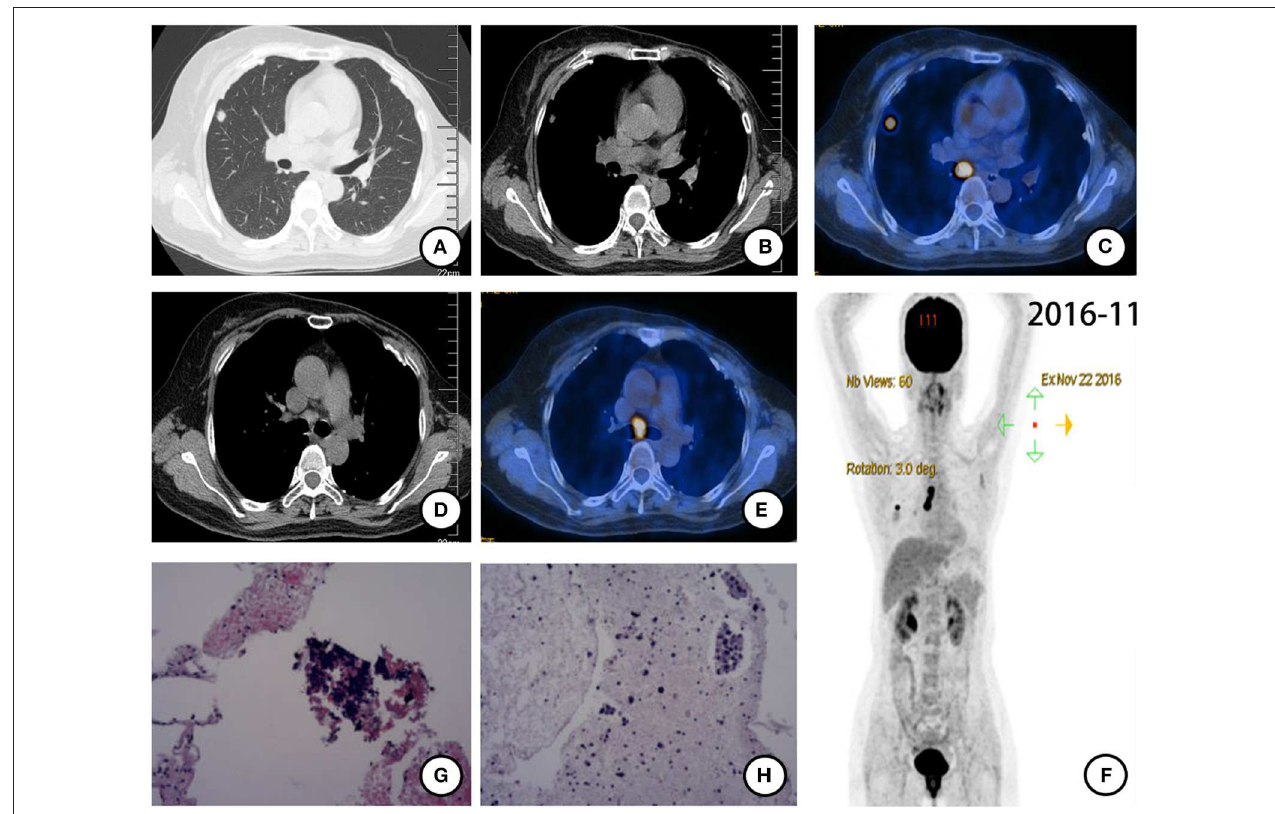
FIGURE 1 | PET-CT scan (November 2016) and histopathological results after postoperative recurrence. (A) Solitary right pulmonary nodule and (B) enlarged right hilar lymph node were found and identified as metabolically active lesions (SUVmax = 8.32) (C) . (D,E) Subcarinal lymph node enlarged with intense FDG uptake (SUVmax = 13.19). (F) Holistic view of PET-CT: metabolic lesions in the lung, hilum, and subcarina. (G) Histopathological features of CT-guided biopsy tissue of the nodule in the right upper lobe: alveolus tissue with some naked nuclear-like lymphocytes. ( × 20 hematoxylin/eosin). (H) Histopathological features of EBUS biopsy tissue of the subcarinal lymph node: cancer cells arranged in disperse or the nest bulk in mucoid tissue ( × 20